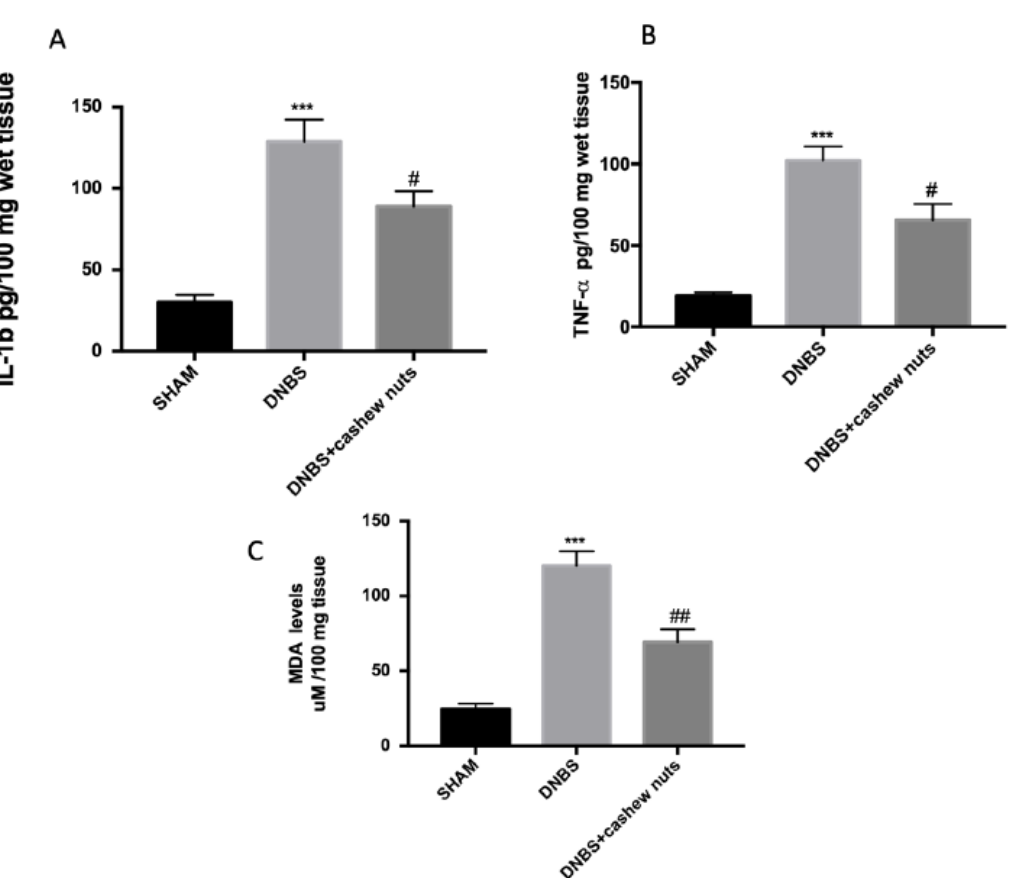
Figure 5. The e ff ects of cashew nuts on cytokine and MDA levels. IL-1 β ( A ), TNF- α ( B ), MDA ( C ) levels were examined in all groups. Cashew nuts treatment reduces cytokines and MDA levels. Values = means ± SEM of six animals in each group; *** p < 0.001 vs. sham; # p < 0.05 vs. DNBS. ## p < 0.01 vs.